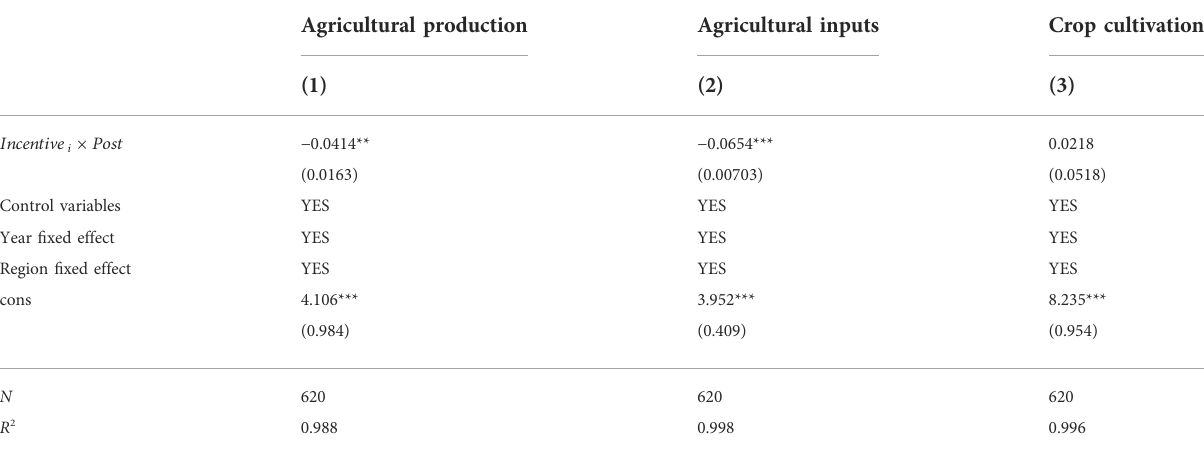
TABLE 9 Heterogeneity analysis Ⅱ